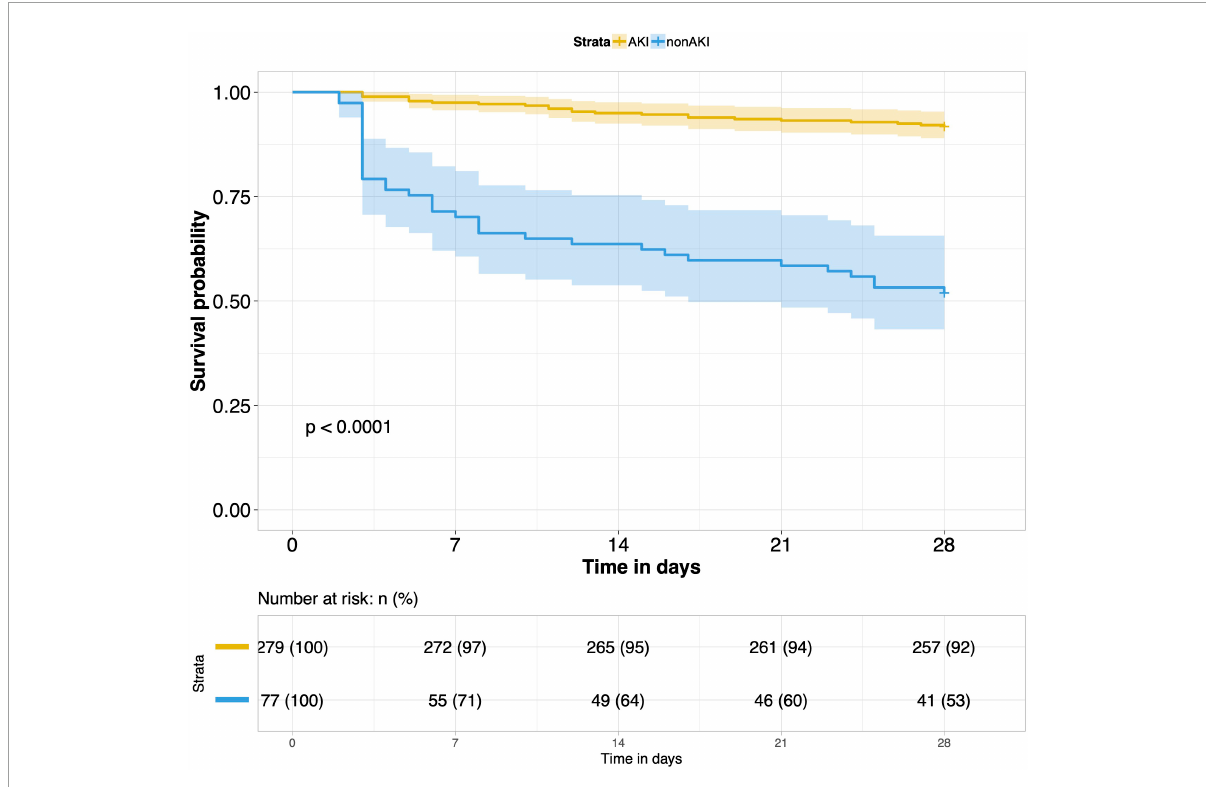
( P = 0.04) ( Figure 4 ). Bivariate correlation analysis of these three variables showed that there was a positive correlation between septic shock and lactate ( P < 0.001, r = 0.330), a positive correlation between septic shock and SOFA score ( P < 0.001, r = 0.413), and a positive correlation between lactate and SOFA score ( P < 0.001, r =